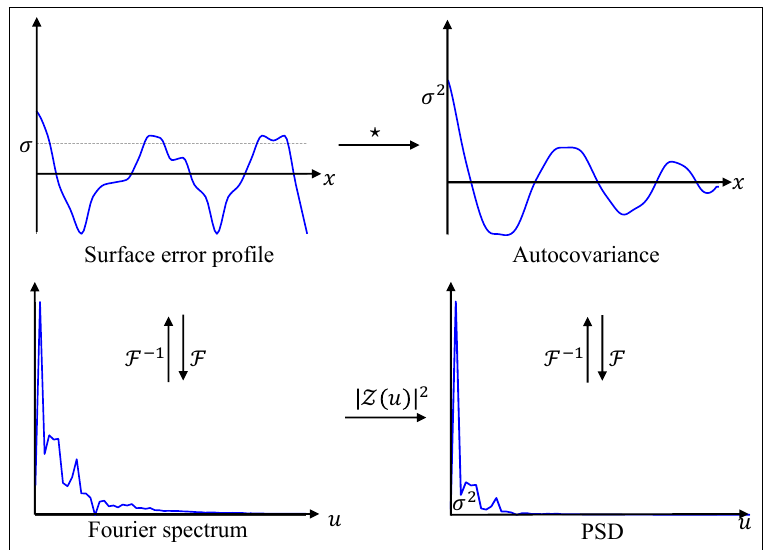
Figure 1. Schematic of the relationship between relevant surface parameters, where “ (cid:63) ” is the auto- correlation operator, F and F − 1 represent the forward and inverse Fourier transforms, respectively, and σ 2 is the variance of the surface